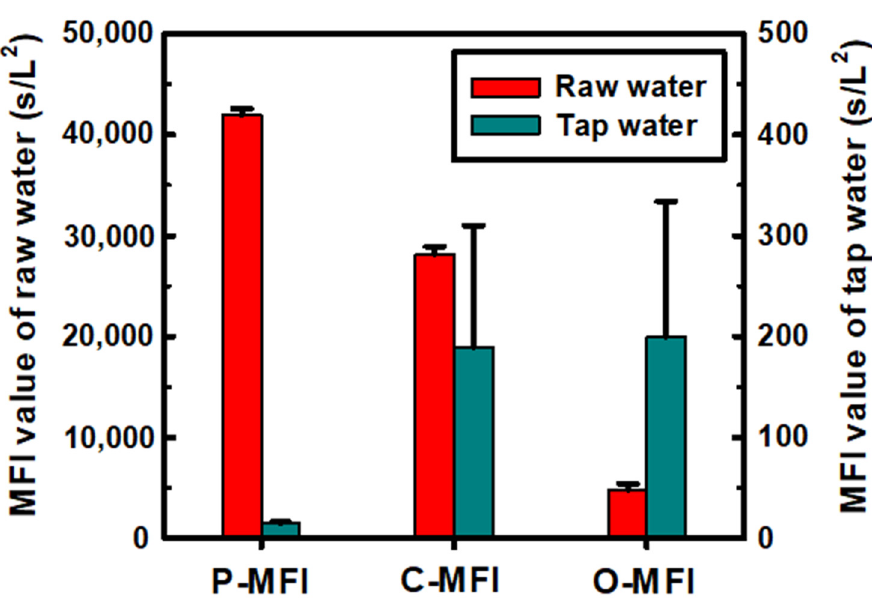
Figure 6. Fouling potential of water samples in real raw water and tap water.